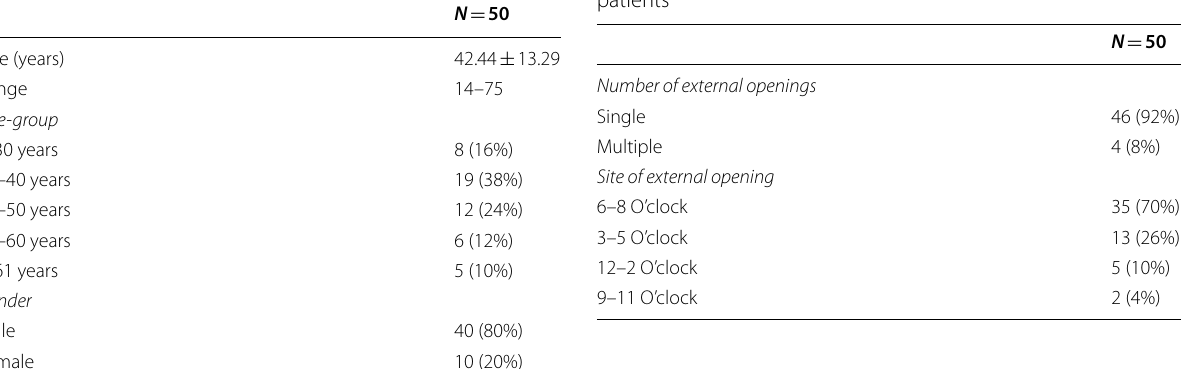
Table 3 Demographic data of enrolled patients